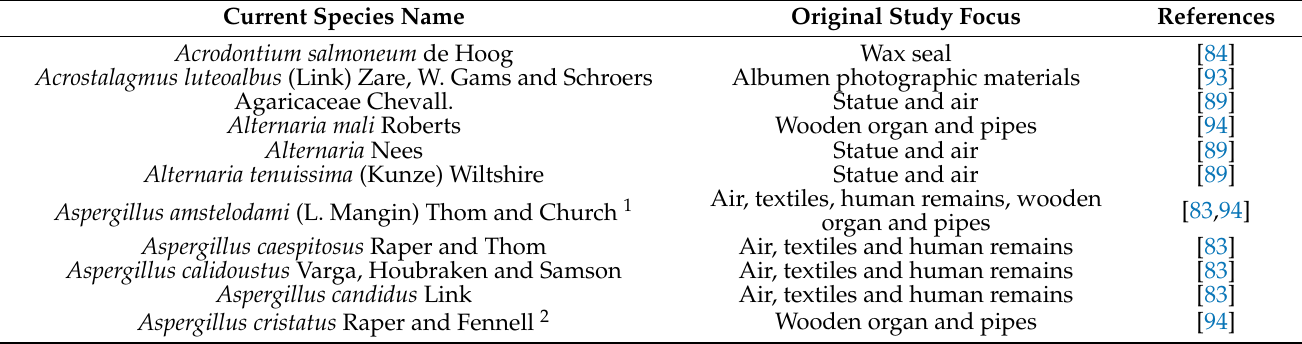
Table 7. Overview of fungal species for which isolates have been identified as displaying lipolytic abilities in biodeteriorative plate